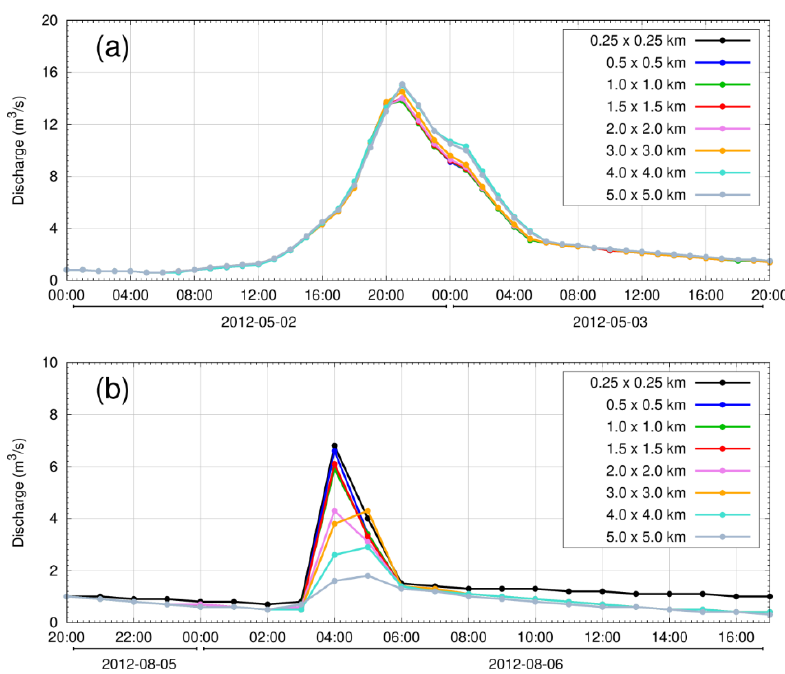
Figure 10. Time series profile of the simulated discharge at the outlet of the Tsurumi River Basin for the events of ( a ) 2–3 May 2012 (WR_N1), and ( b ) 5–6 August 2012 (CR_N1).